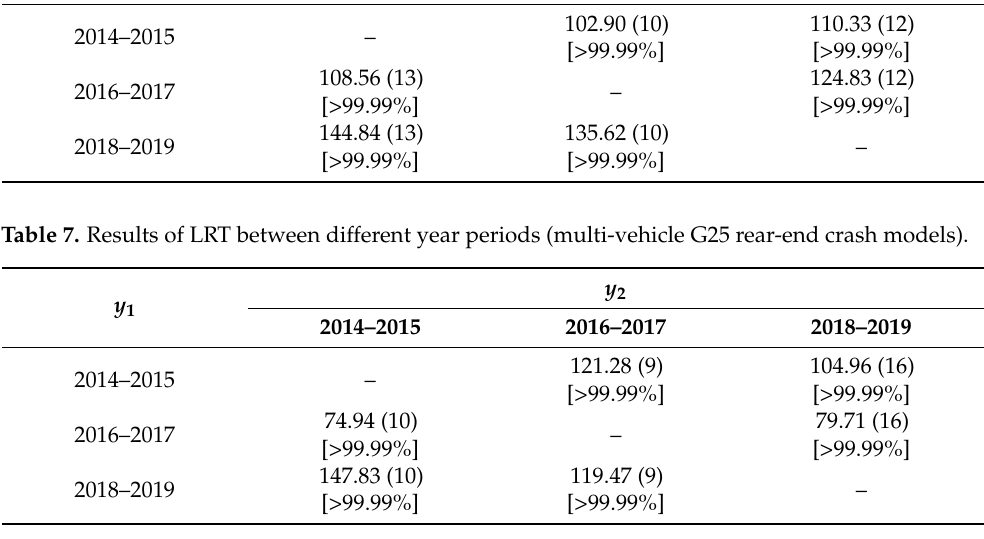
Table 6. Results of LRT across year periods (two-vehicle G25 rear-end crash models). y 1